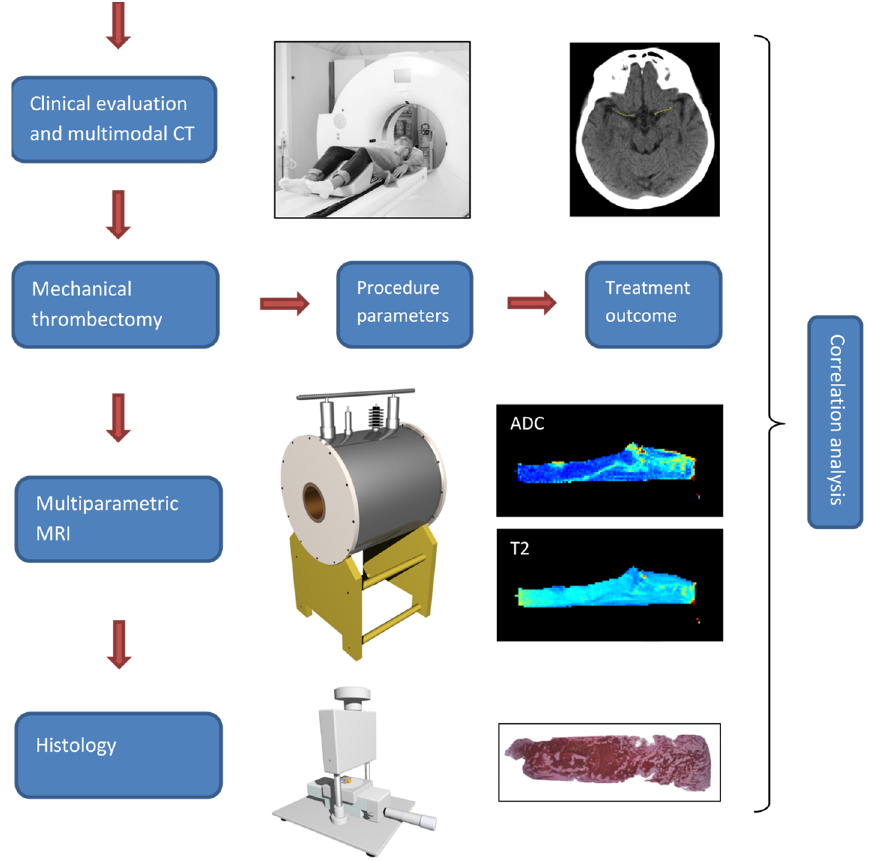
Figure 1. Study design. Patients suspected with an acute stroke underwent clinical examination and a CT scan. If ischemic stroke was confirmed and the thrombolysis was unsuccessful, the patients received further therapy by mechanical thrombectomy. The thrombi retrieved from the MCA vessel segment were further analyzed by high spatial resolution multiparametric MRI and histology. Dif- ferent parameters obtained from imaging (CT, MRI and histology) and the interventional procedure and treatment were then analyzed for possible